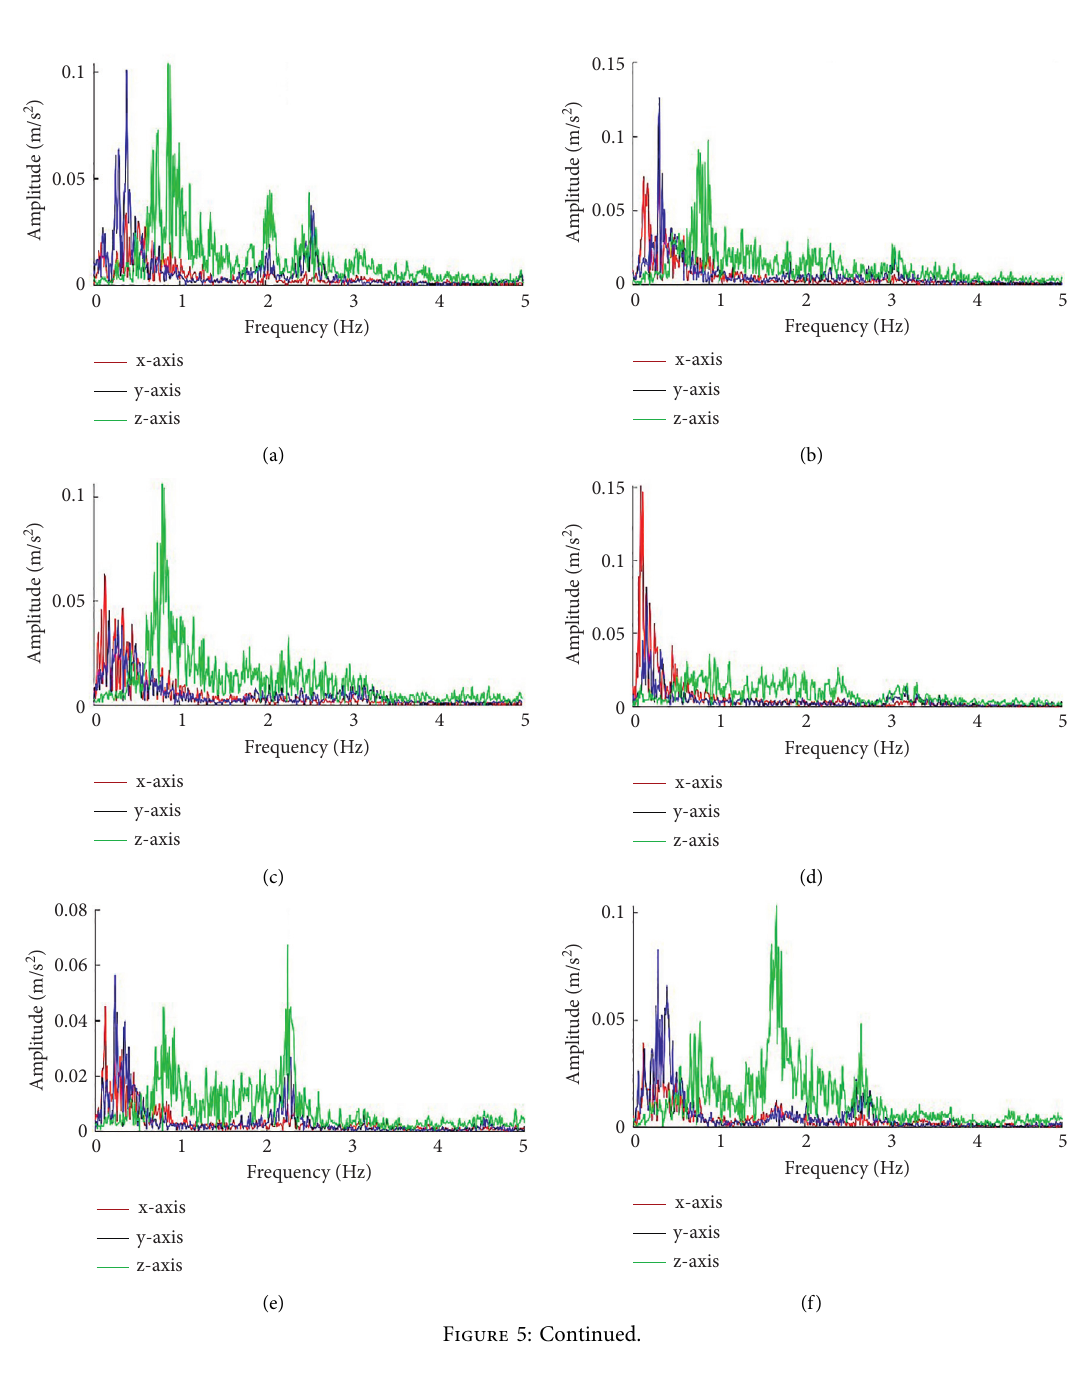
Table 2: Analysis of variance for S